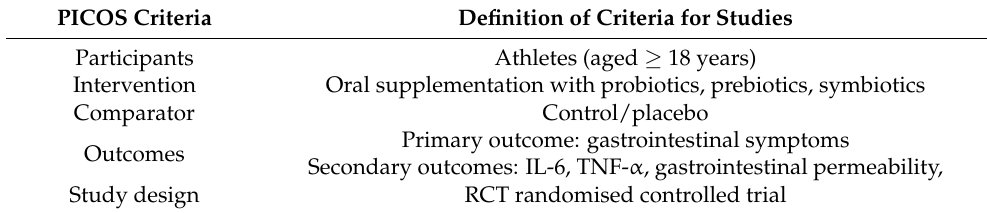
Table 1. PICOS criteria for inclusion of studies. PICOS